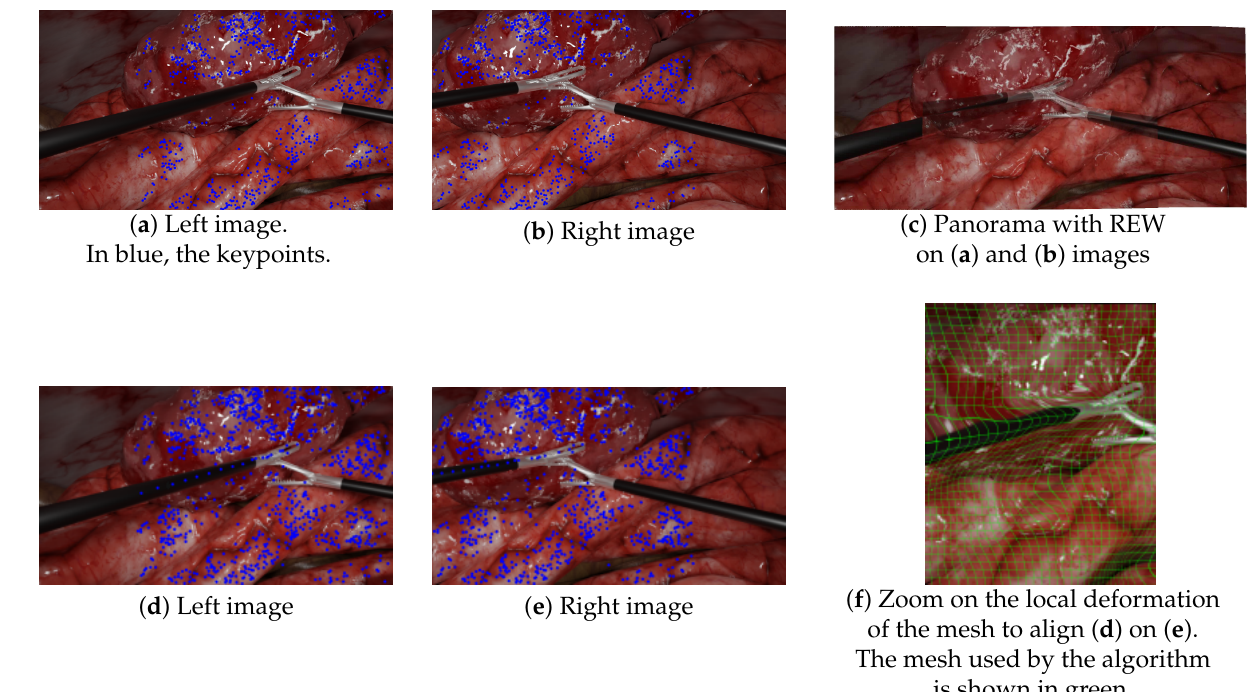
Figure 9. Illustrations of the mesh-based model (REW) failure to provide satisfying results. ( a , b ) SURF keypoint detection on the left and right input images. ( c ) The resulting panorama did not align the forceps at all (ghosts), since mesh-based models, such as REW, rely on keypoint matching—keypoints that were missing on the laparoscopic forceps. ( d – f ) The same experiments with manually added keypoints along the left tool. REW aligned the tools but induced deformations as illustrated in ( f